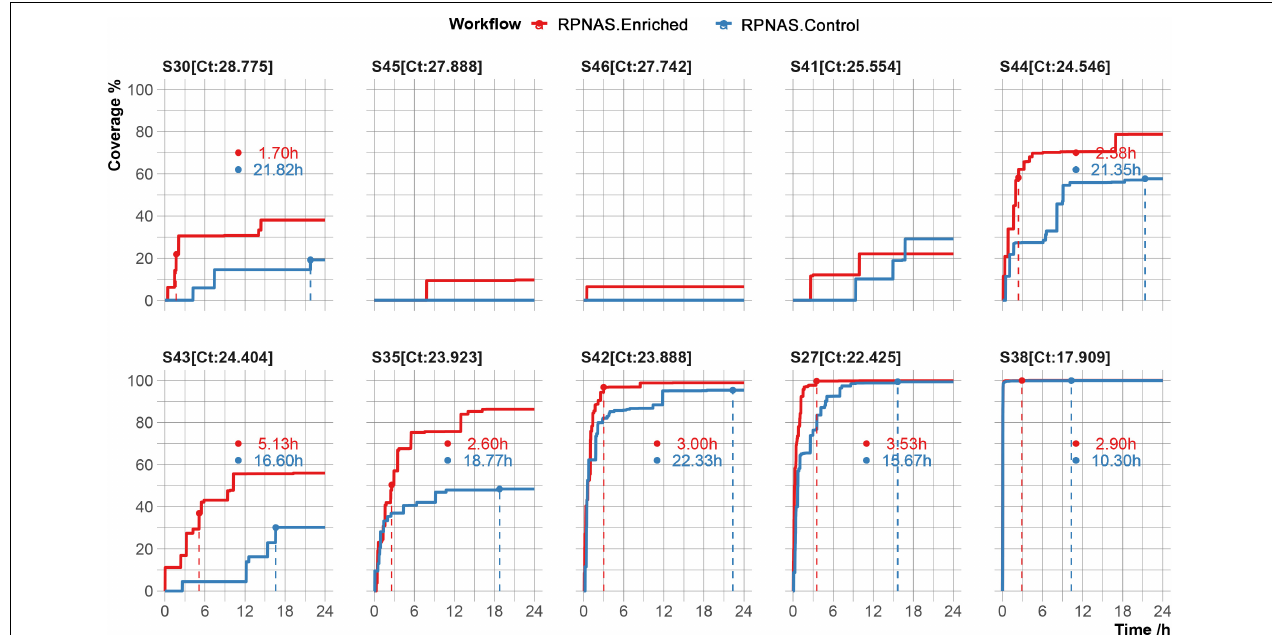
FIGURE 4 | Genome coverage of the severe acute respiratory syndrome coronavirus 2 (SARS-CoV-2) reference over 24 h in 10 samples. The time to reach the max coverage of the control group is indicated by the dotted lines.